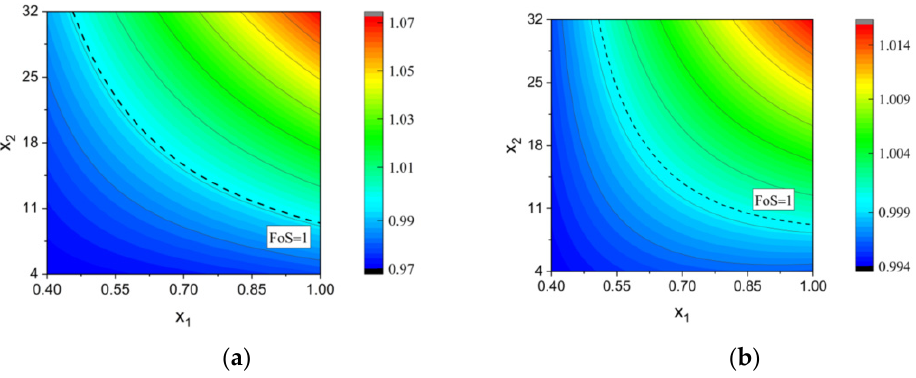
Figure 17. 2D contour plot of the generated response surface for ( a ) compressive and ( b ) shear buckling.